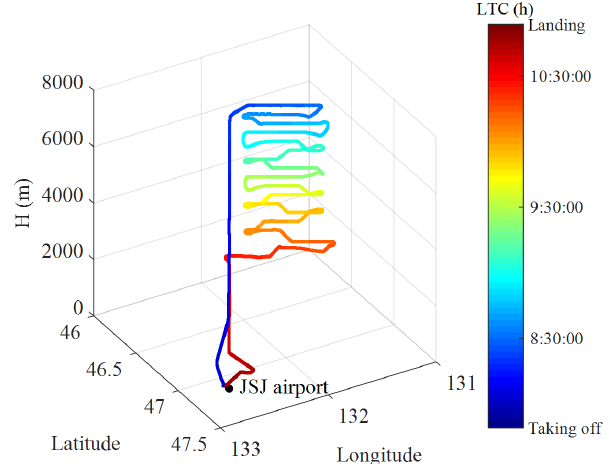
Figure 4. Trajectory on 7 August 2018 in Jiansanjiang. The color scale shows the progression of time (LTC), where blue represents the start time of the data profile, and red represents the end time.